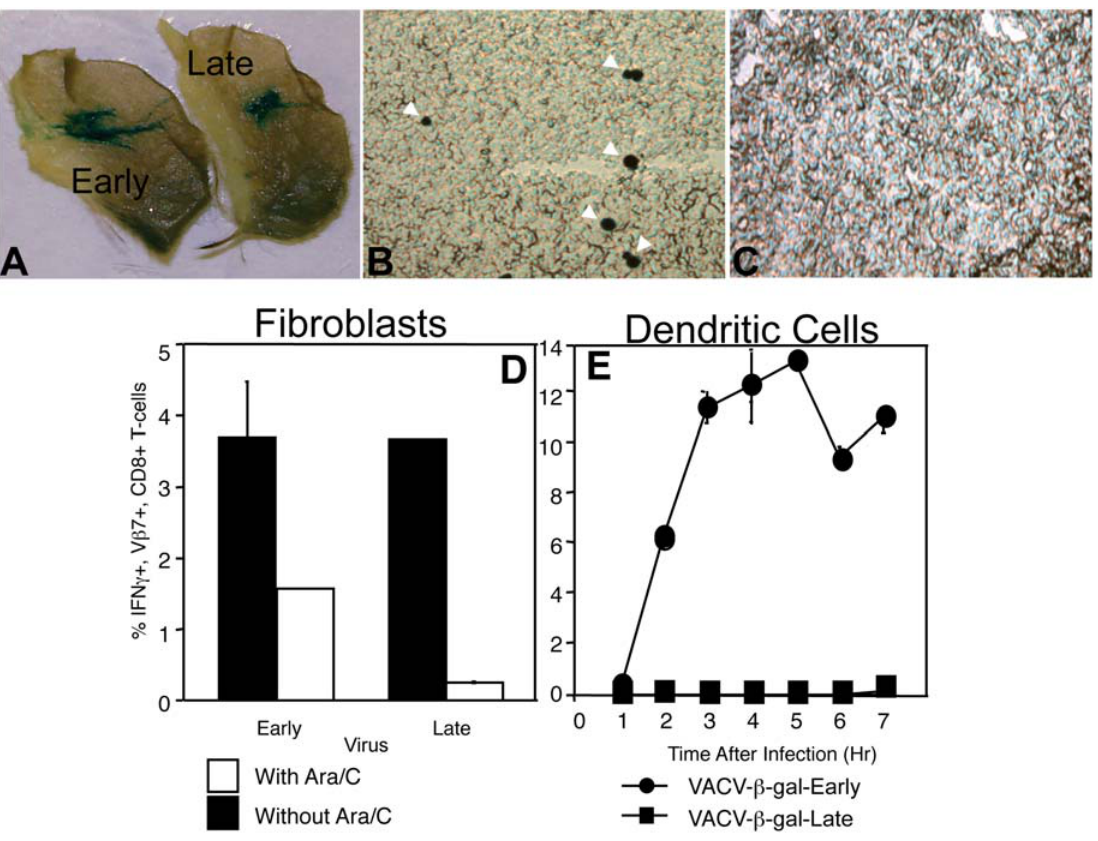
Figure 3. Late promoter-driven b -gal is not produced in pAPC invivo or presented to T CD8 + by infected BMDC. Production of b -gal was visualized in vivo following i.d. infection in the ear pinnae at the site of infection (A) and draining lymph nodes [(B) Early, (C) Late]. (D) Direct presentation by fibroblasts infected with rVACV- b -gal-Early or rVACV- b -gal-Late was measured by analyzing IFN- c production from b -gal 96–103 -specific T CD8 + in the presence (white bars) or absence (black bars) of ara/c, which will block production of late genes. (E) Similarly, direct presentation by BMDC infected with rVACV- b -gal-Early ( $ ) or rVACV- b -gal-Late ( & ) was measured by analyzing IFN- c production from b -gal 96–103 specific T CD8 + .